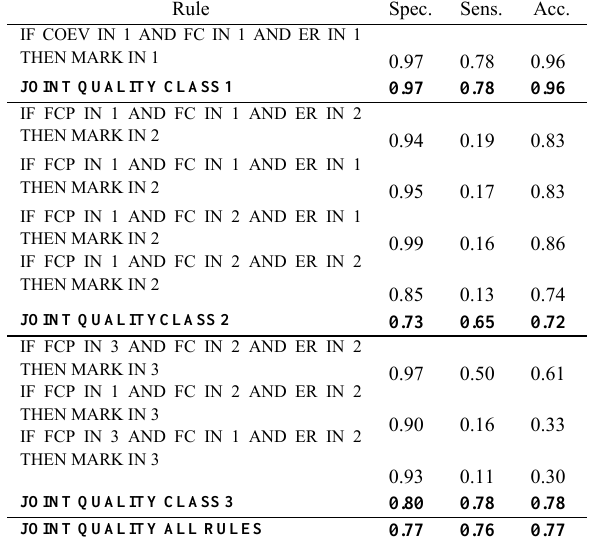
Table 15. Linguistic rules FIR model and its metrics (fuzzification parameters defined by the GA with variable MARK